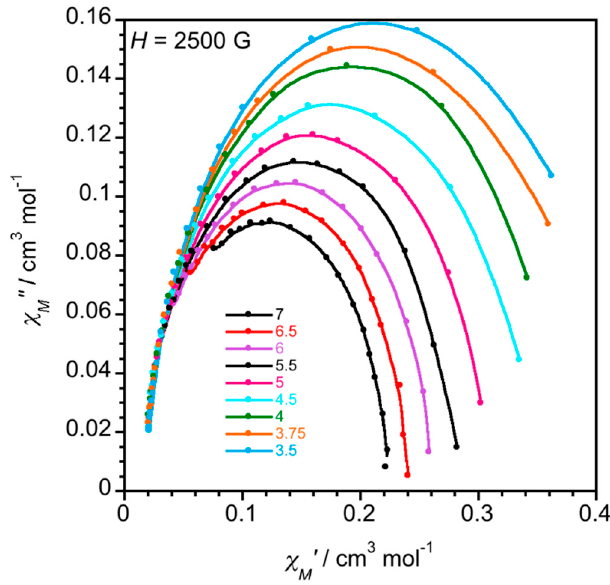
Figure 7. Cole–Cole plots in the temperature range 3.5–7.0 K for 1 under an applied static field H dc = 2500 G. The solid lines are the best-fit curves.